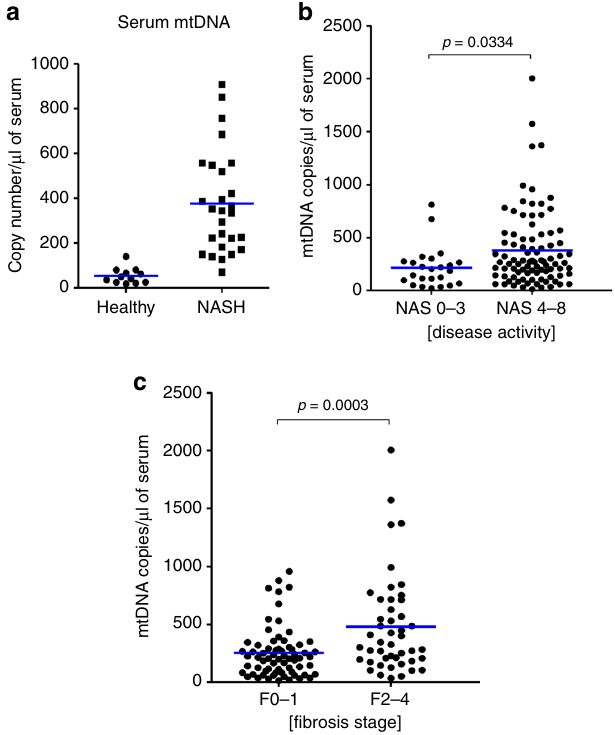
Fig. 7 Circulating mito-DAMP levels are elevated in patients with NASH in association with histologically signi fi cant hepatic fi brosis. Characteristics of the healthy human subjects and treatment-naive patients with biopsy-proven NAFLD/NASH are summarized in Table 1. a Serum levels of mtDNA are markedly elevated in the sera of patients with NAFLD/ NASH (cohort I, n = 27) compared to healthy subjects ( n = 11). Increased mtDNA levels in relation to histological NAFLD/NASH disease activity ( b ) and fi brosis ( c ) (cohort II, n = 114). mtDNA (D-loop region) was quanti fi ed by real-time TaqMan PCR in total DNA isolated from serum as described in “ Methods ” (dot-plot depict individual values, bar shows group average, two-tailed p value indicated, unpaired t test). Source data are provided as a Source Data fi